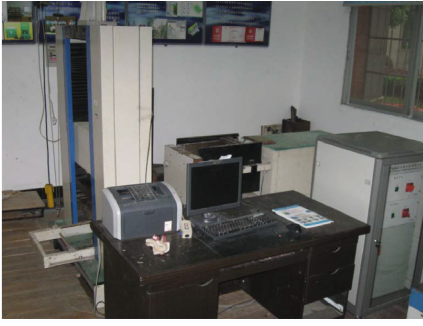
Figure 4: RYL-600 rock shear tester.